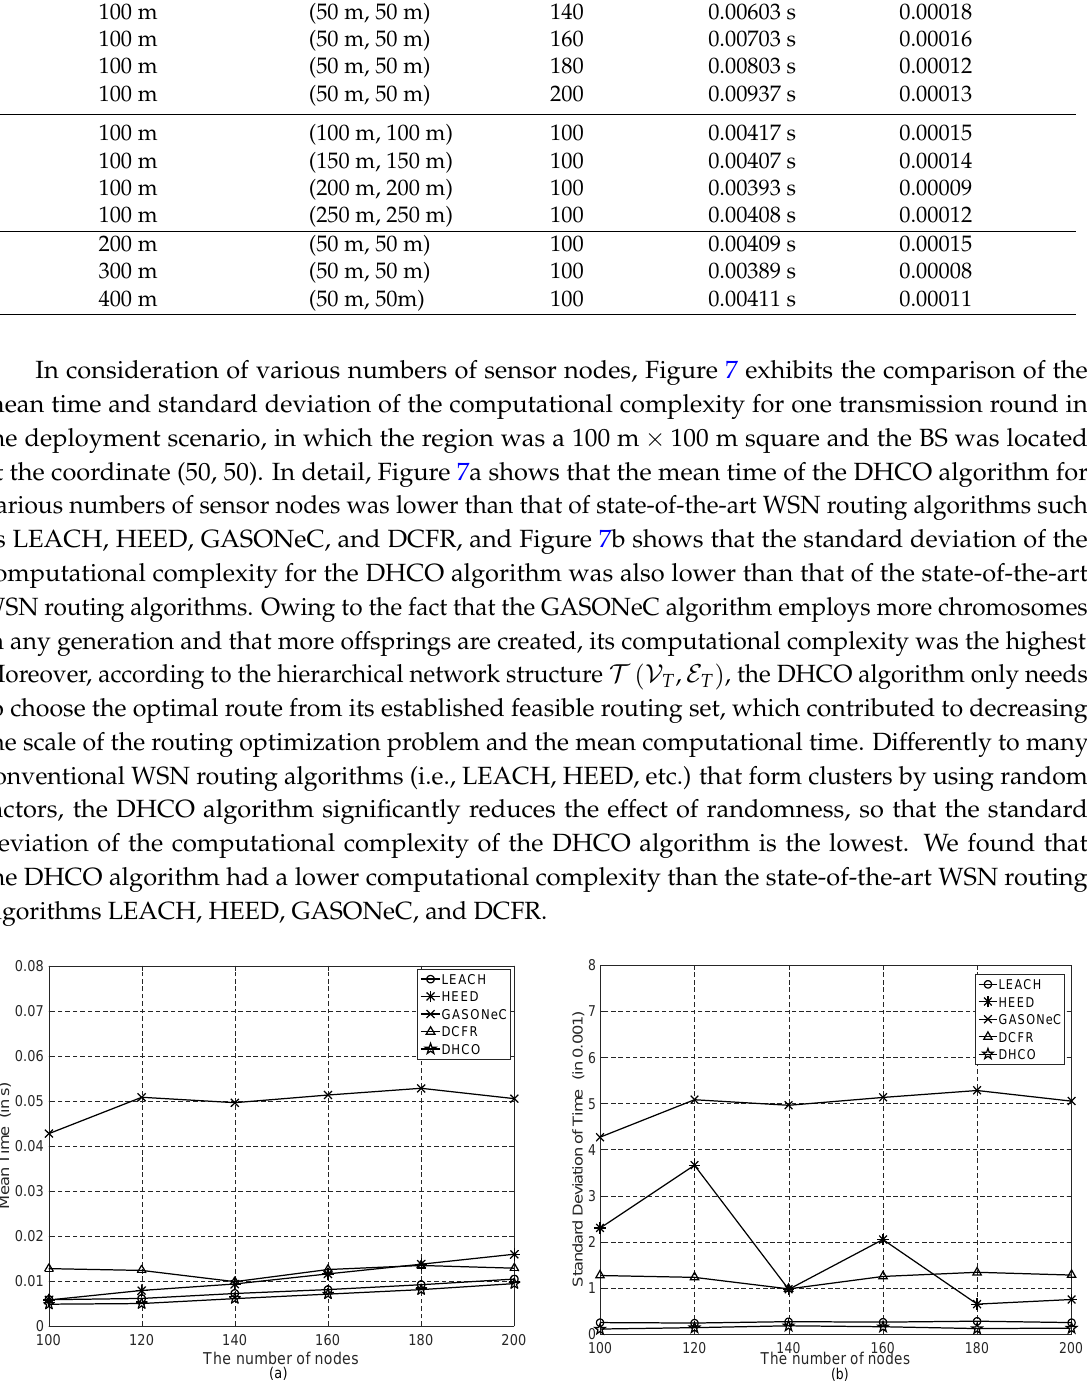
Figure 7. Comparison of the mean time and standard deviation of the computational complexity for each transmission round in the deployment scenarios of the 100 m × 100 m square region and the coordinate (50, 50) of the BS: ( a ) mean time for diverse numbers of sensor nodes, and ( b ) standard deviation of the computational complexity for diverse numbers of sensor